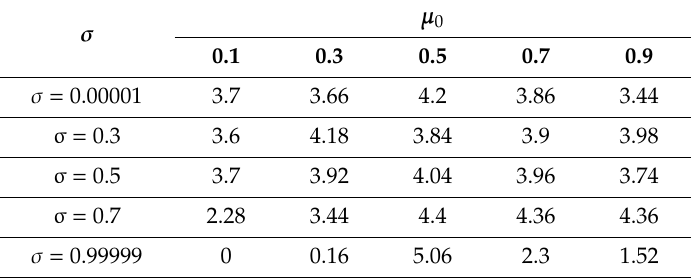
Figure 6. The relationship diagram among Table 3. The time T based on di ff erent σ and µ 0